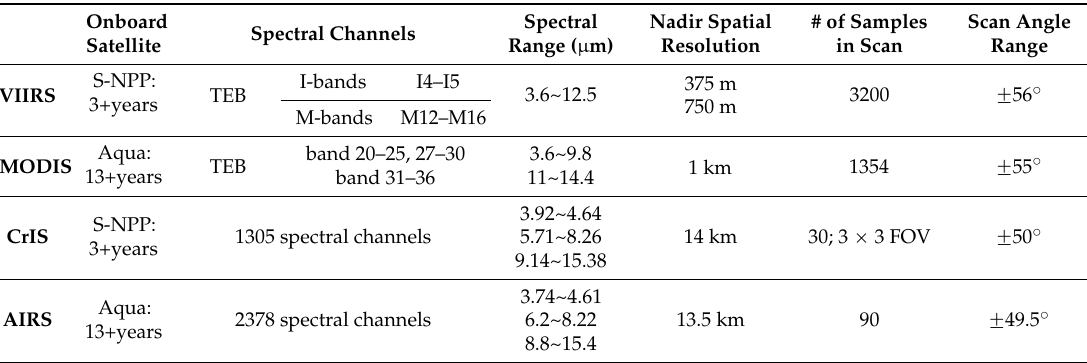
Table 1. VIIRS, MODIS, AIRS, and CrIS spectral